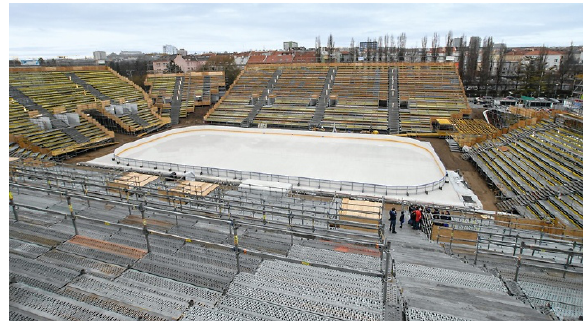
Figure 5. Construction of grandstands in Brno